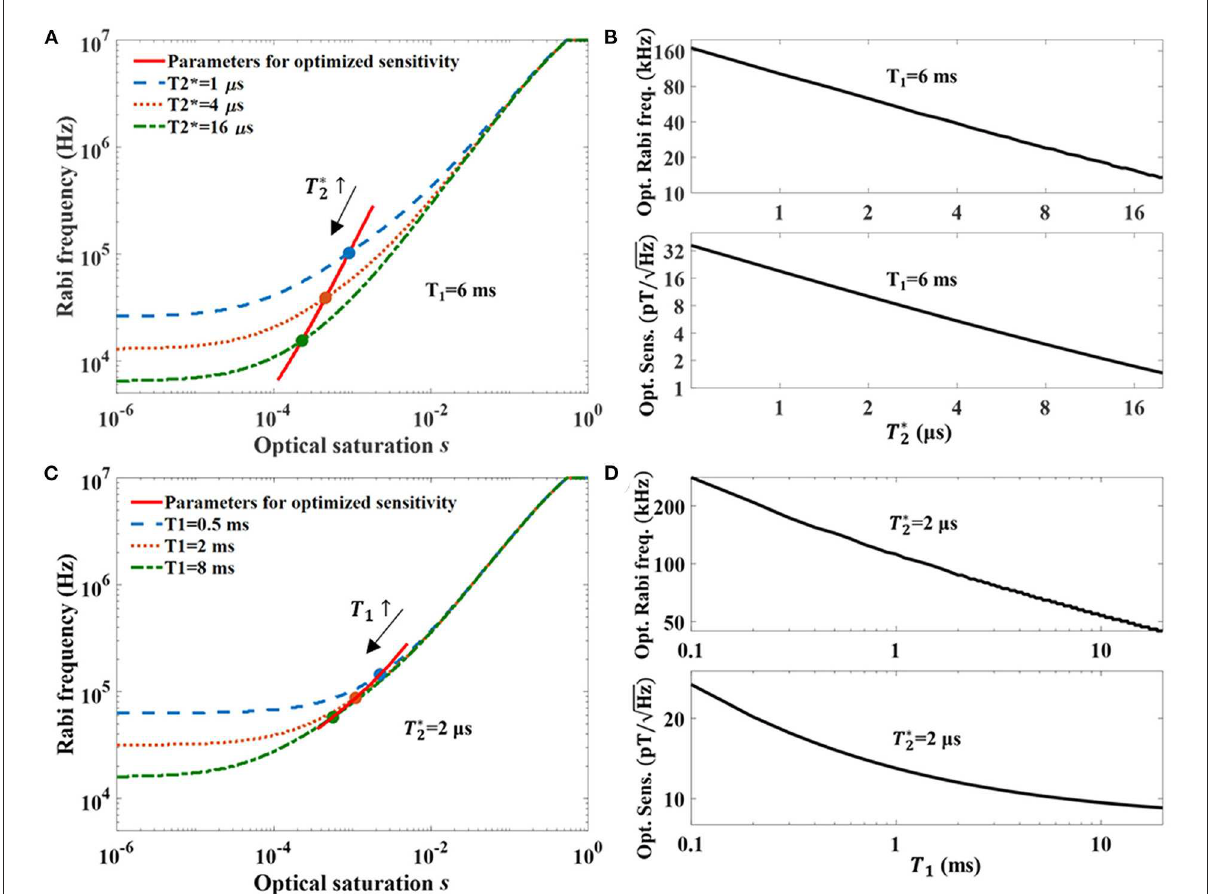
FIGURE3 (A) Optimization of parameters for the sensitivity of CW-ODMR NV-magnetometry. The three curves (dash, dot, and dash-dot) indicate the Rabi frequencies for the optimized sensitivities with different laser powers. The different curves use different T ∗ 2 for the calculations. The solid line plots both the laser powers and the Rabi frequencies of the optimized sensitivities for different T ∗ 2 , and the dots are the crossing spots with the other three curves. (B) The upper graph shows that the optimal Rabi frequency is logarithmically linear to the T ∗ 2 of the diamond. The lower graph shows that the calculated optimized sensitivity is also logarithmically linear to the T ∗ 2 . (C) Optimization of parameters for sensitivities of diamonds with different T 1 . The curves for different T 1 are calculated with T ∗ 2 2 µ s . The solid line indicates the parameters for optimized = sensitivity with different T 1 . (D) The upper graph shows the relationship of the optimal Rabi frequency for different T 1 , and the lower graph shows the best sensitivities that can be achieved by the diamonds with different T 1